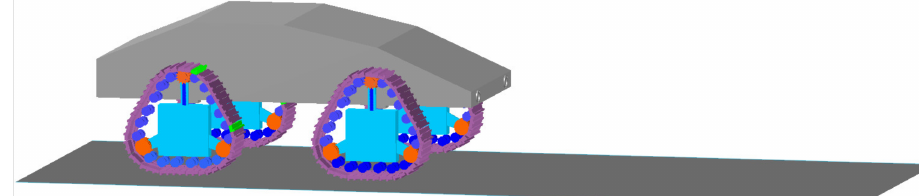
Figure 10. Model of the reconfigurable wheel-crawler robot.